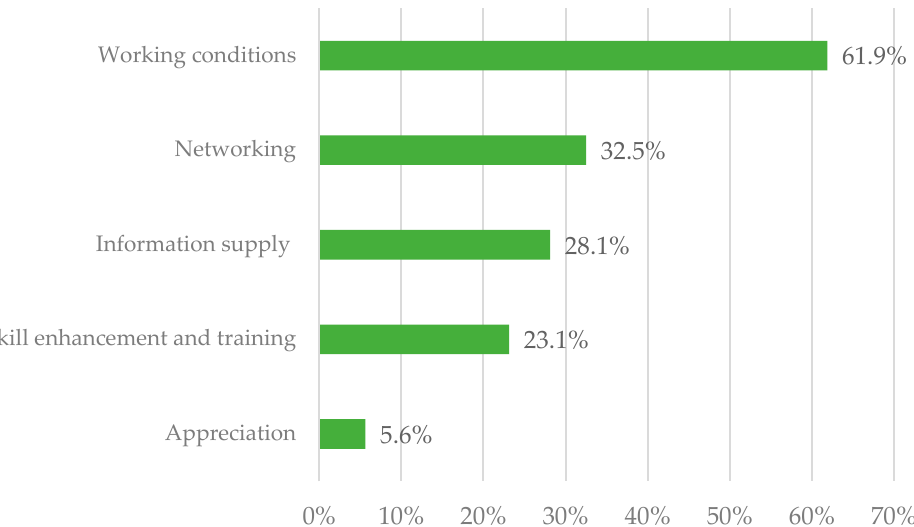
Figure 6. Support wishes. The percentages of psychotherapists reporting each main category of re- sponse that emerged from the open-ended question, “What support concerning your professional activity as a psychotherapist would you wish for?”